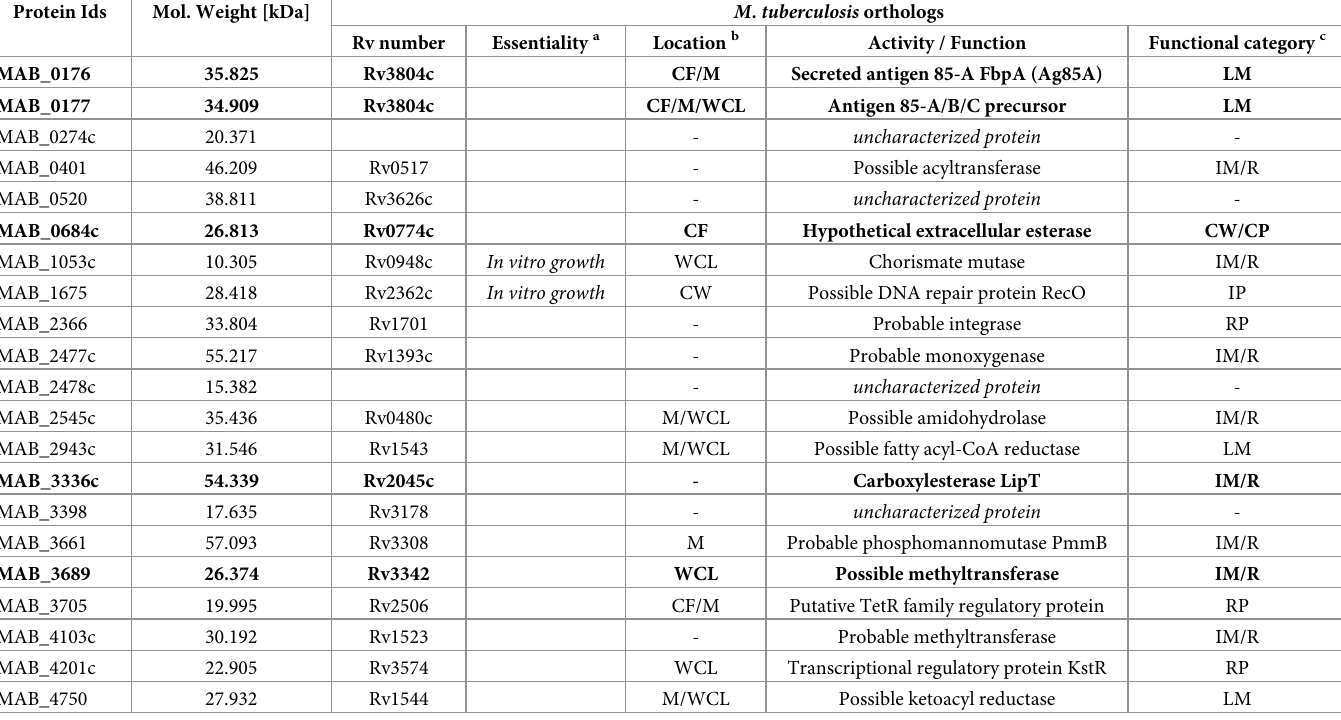
In bold , the 5 proteins identified at a pFDR of 1%.